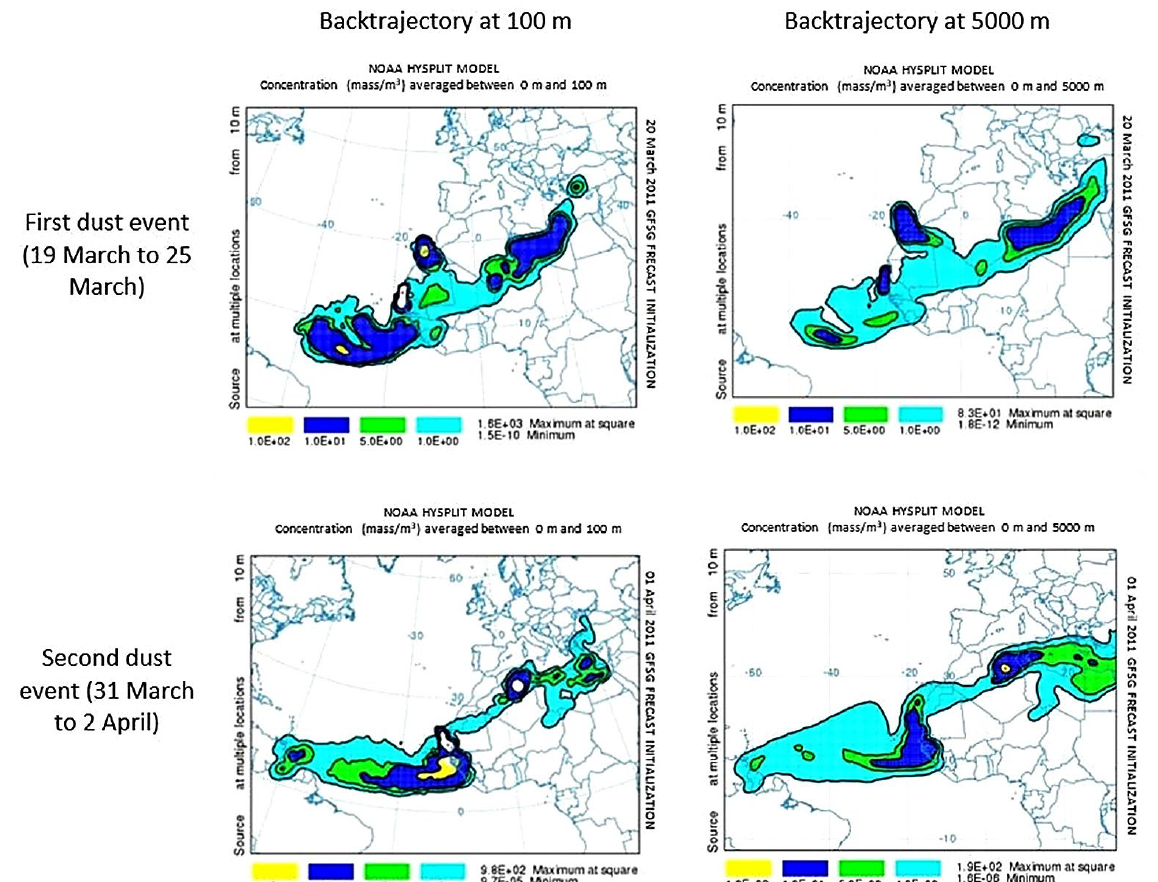
Fig. 3. – Back trajectory of dust events analysed: 19 March to 25 March and 31 March to 2 April. The origin of the dust event is localized to western Algeria, northern Mauritania and the Western Sahara, relatively close to the sample area (Canary